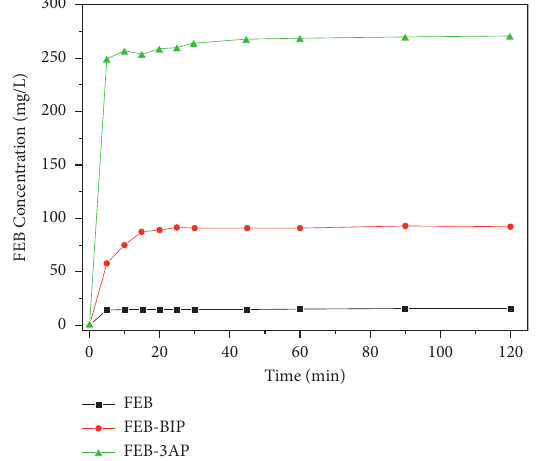
Figure 11: Powder dissolution profiles of FEB, FEB-BIP, and FEB- 3AP at different time points in pure water at 37 °